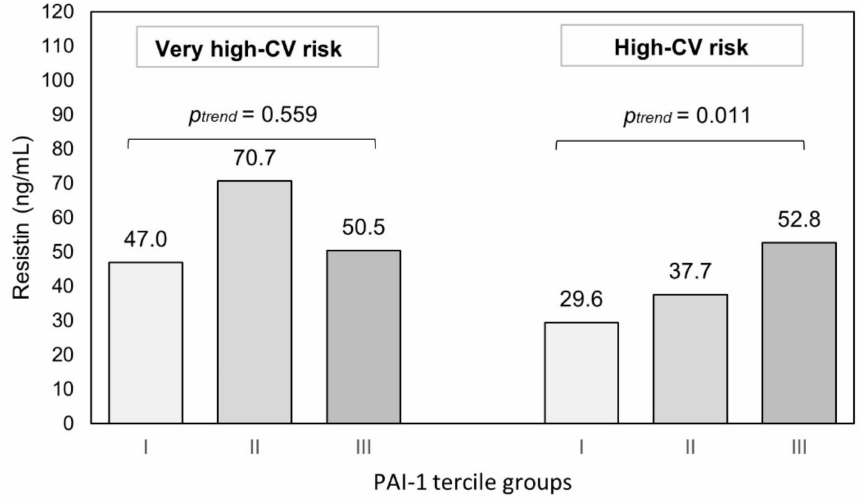
Figure 1. Resistin concentration and PAI-1 levels (tercile groups) in CKD patients by level of CV risk. In patients with eGFR ≥ 60 mL/min/1.73 m 2 , serum PAI-1 concentrations were associ- ated with the level of resistin but due to the small group of participants without CKD, the esti- mation of variables was not justified. However, in patients with eGFR ≥ 60 mL/min/1.73 m 2 and very high-, high- and moderate-CV risk, the PAI-1 concentrations rose with the increase of resistin level, regardless of CV risk. For patients with very high-CV risk, the Spear- man correlation coefficient was 0.900 ( p = 0.037) for individuals with high-CV risk—0.510 ( p = 0.022) and for participants with moderate-CV risk—0.464 ( p = 0.095). We did